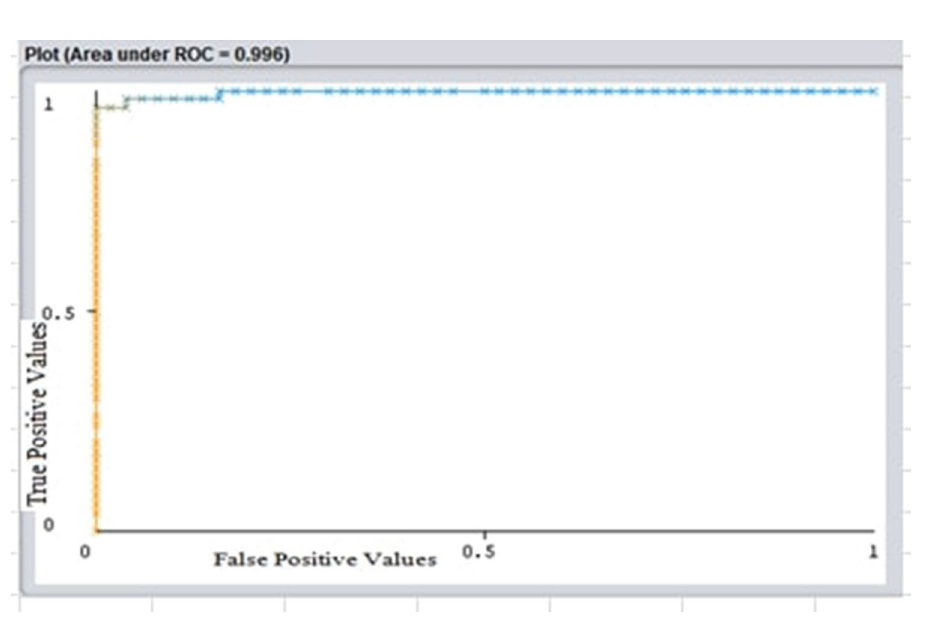
Figure 3. ROC curve of Naïve Bayes